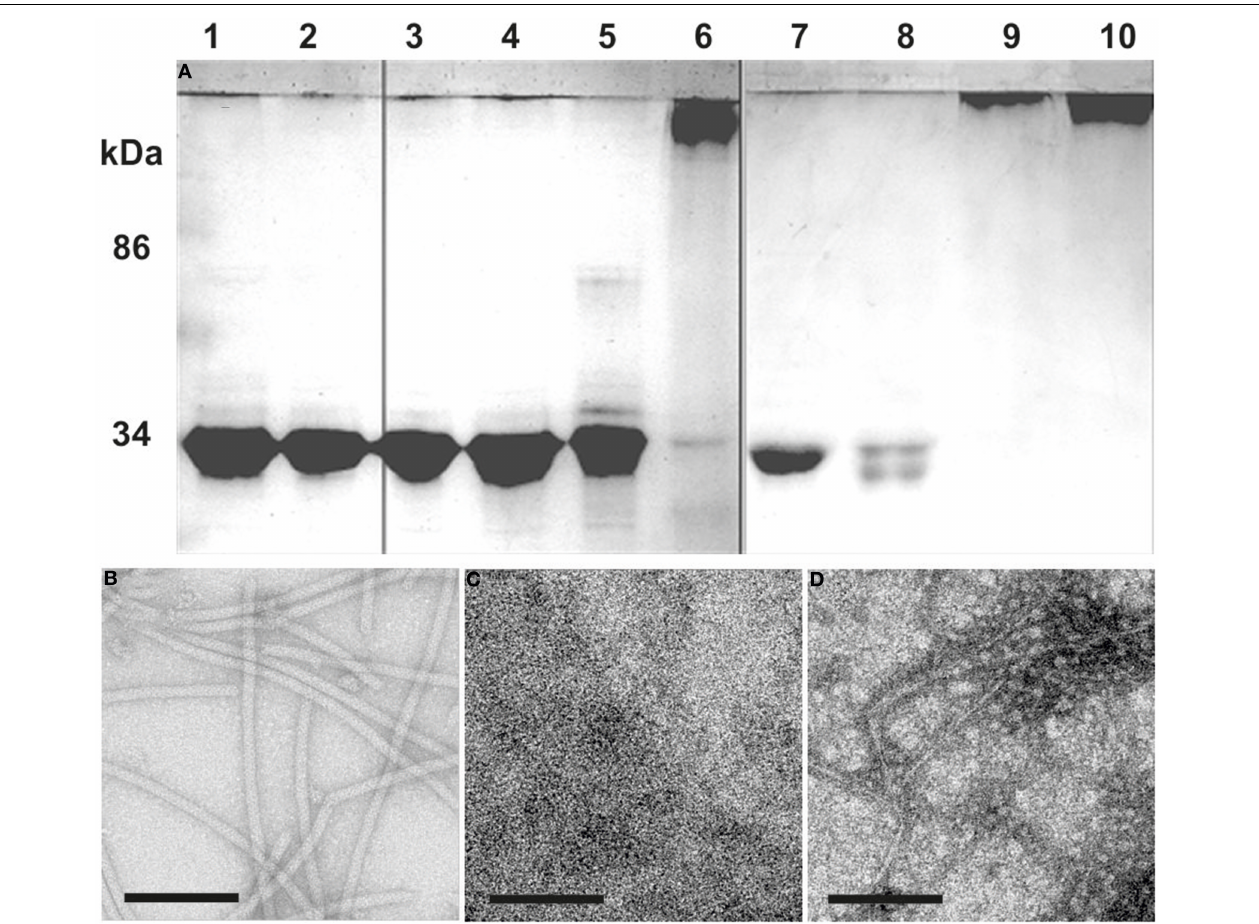
FIGURE 3 | Repolymerization of denatured flagella. (A) SDS-PAGE: Flagella purified by CsCl-gradient centrifugation were denatured into monomeric flagellins by SDS and heat denaturation (lane 1). After extensive dialysis against 5mM HEPES buffer only single flagellins were observed (lane 2). The denatured flagellins were used for polymerization assays at: 8 ◦ C